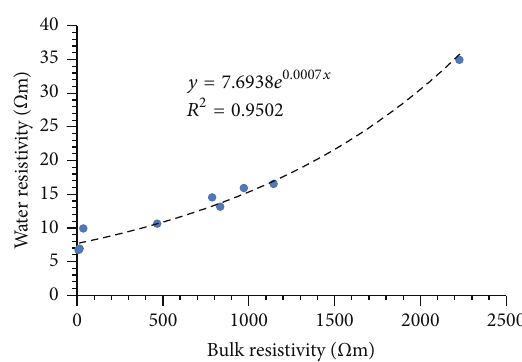
Figure 10: A graph of third layer water resistivity against bulk